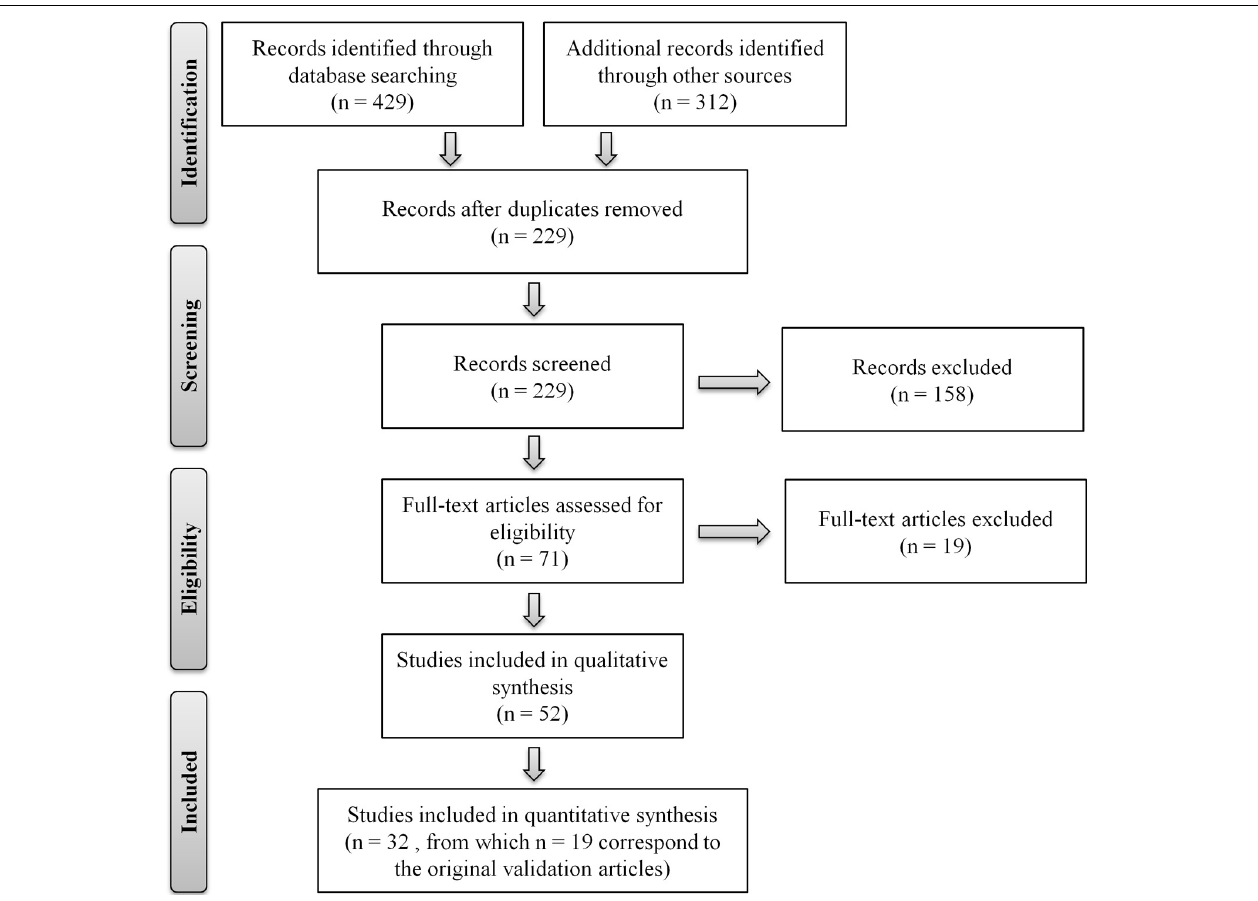
FIGURE 1 | Flow diagram of the literature review. Depiction of the flow of information through the different phases of the review. PRISMA flow diagram template (Moher et al.,